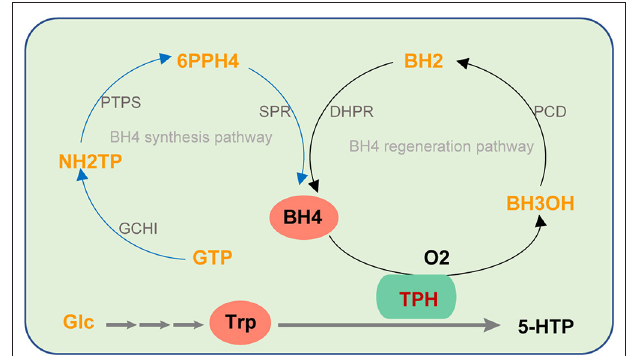
FIGURE 2 | The biosynthesis pathway of 5-HTP catalyzed by TPH using BH 4 as a cofactor. The blue line represents the BH 4 synthesis pathway. The black line represents BH 4 regeneration